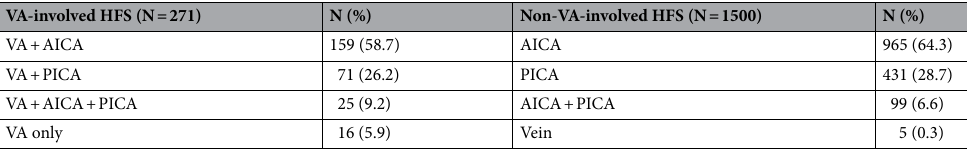
Table 1. Offending vessels in VA-involved and non-VA-involved HFS. HFS hemifacial spasm, VA vertebral artery, AICA anterior inferior cerebellar artery, PICA posterior inferior cerebellar artery.